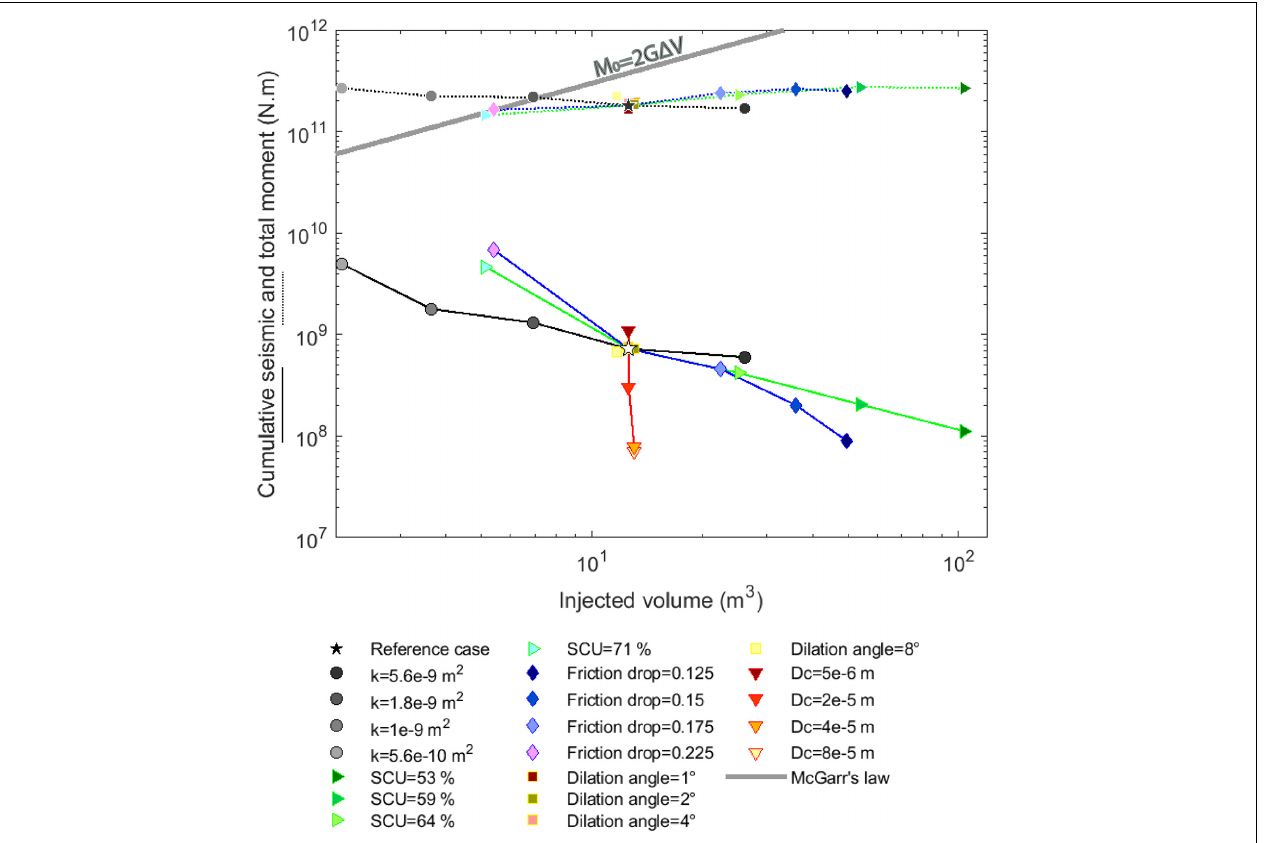
FIGURE 7 | Cumulative seismic (solid line) and total moment (dashed line) as a function of total injected fluid volume for the 21 simulations ( Table 2 ). Injection tests with a same varying parameter are linked by a single-colored line. Each test is defined by a color and a symbol. The reference case is represented by a white (for the seismic moment) or black (for the total moment) star. The gray thick diagonal line shows the upper bound given by Eq. (5) of McGarr and Barbour